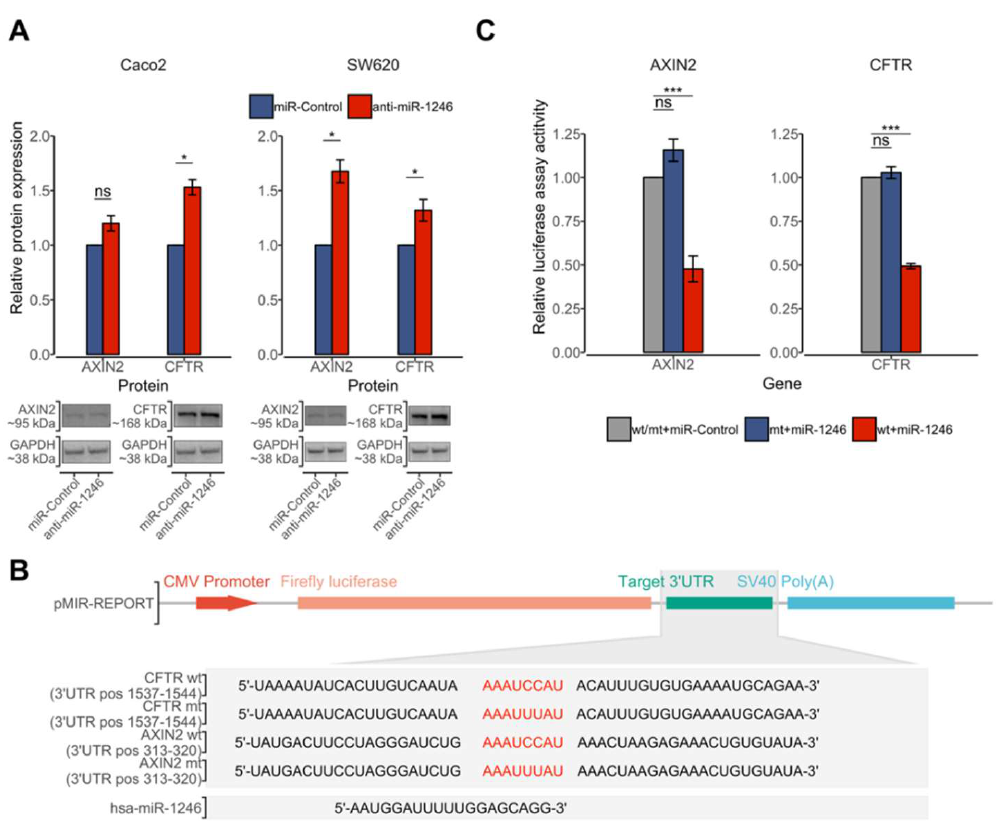
Figure 3. hsa-miR-1246 suppresses expression of CFTR and AXIN2 via direct 3’UTR targeting. ( A ) Effect of hsa-miR-1246 inhibition on CFTR and AXIN2 protein expression compared with negative control (miR-Control) measured at 72 h after transfection of Caco-2 and SW620 cells. Protein bands representing the signals detected by Western blot are provided at the bottom of the panel. Protein expression was normalized to the expression values of GAPDH reference protein. Data from three to four independent experiments presented as the mean of relative protein expression ± standard deviation (SD). ( B ) Representation of constructed pMIR-REPORT vectors containing wild type (wt) and mutant type (mt) 3’UTR sequences of AXIN2 and CFTR genes, which are within the predicted binding sites of hsa-miR-1246. ( C ) Downregulation of AXIN2 and CFTR by hsa-miR-1246 mimics. Luciferase activity of cells transfected with negative controls (miR-Control) was used as a normalization factor and was set at 100%. Data are presented as the mean ± SD of three independent experiments. Luciferase activity significantly decreased in co-transfection with hsa-miR-1246